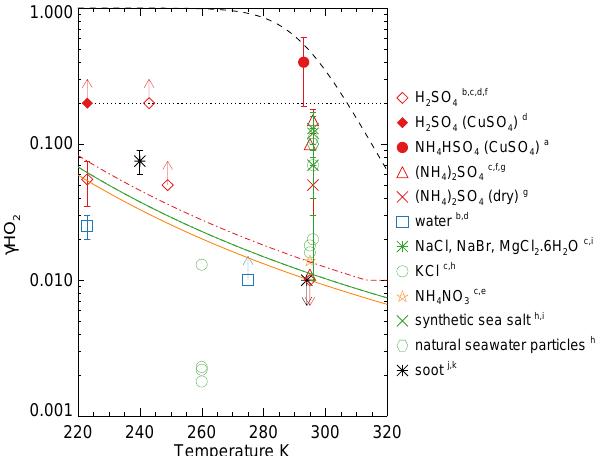
Fig. 1. Summary of laboratory data for γ HO 2 plotted as a function of temperature. Filled symbols denote the aerosol was doped with Cu. The colours indicate composition as follows: red is sulfurous aerosol; green is Cl (orBr)containingsaltsi.e.seasalt;blackissoot;yellowisammoniumnitrate;blueiswater. Solidlinesindicate temperature dependencies on NH 4 NO 3 (Gershenzon et al., 1999), and on solid NaCl (Remorov et al., 2002). Error bars are given if quoted in the reference, and arrows indicate greater than/less than. The dot-dash line indicates the temperature dependence of the parameterisation in this work (assuming 50% relative humidity). The black dotted line indicates a value of 0.2, as recommended by Jacob (2000), and the dashed black line indicates the parameterisation of Thornton et al. (2008) (assuming pH=5, r =100 nm, α =1, [ HO 2 ]=10 8 cm − 3 ), used by Mao et al. (2010). Letters indicate references as follows: (a) Mozurkewich et al., 1987 (b) Hanson et al., 1992 (c) Gershenzon et al., 1995 (d) Cooper and Abbatt, 1996 (e) Gershenzon et al., 1999 (f) Thornton andAbbatt,2005(g)Taketanietal.,2008(h)Taketanietal.,2009(i)Loukhovitskayaetal.,2009(j)Bedjanian et al., 2005 (k) Saathoff et al., 2001.